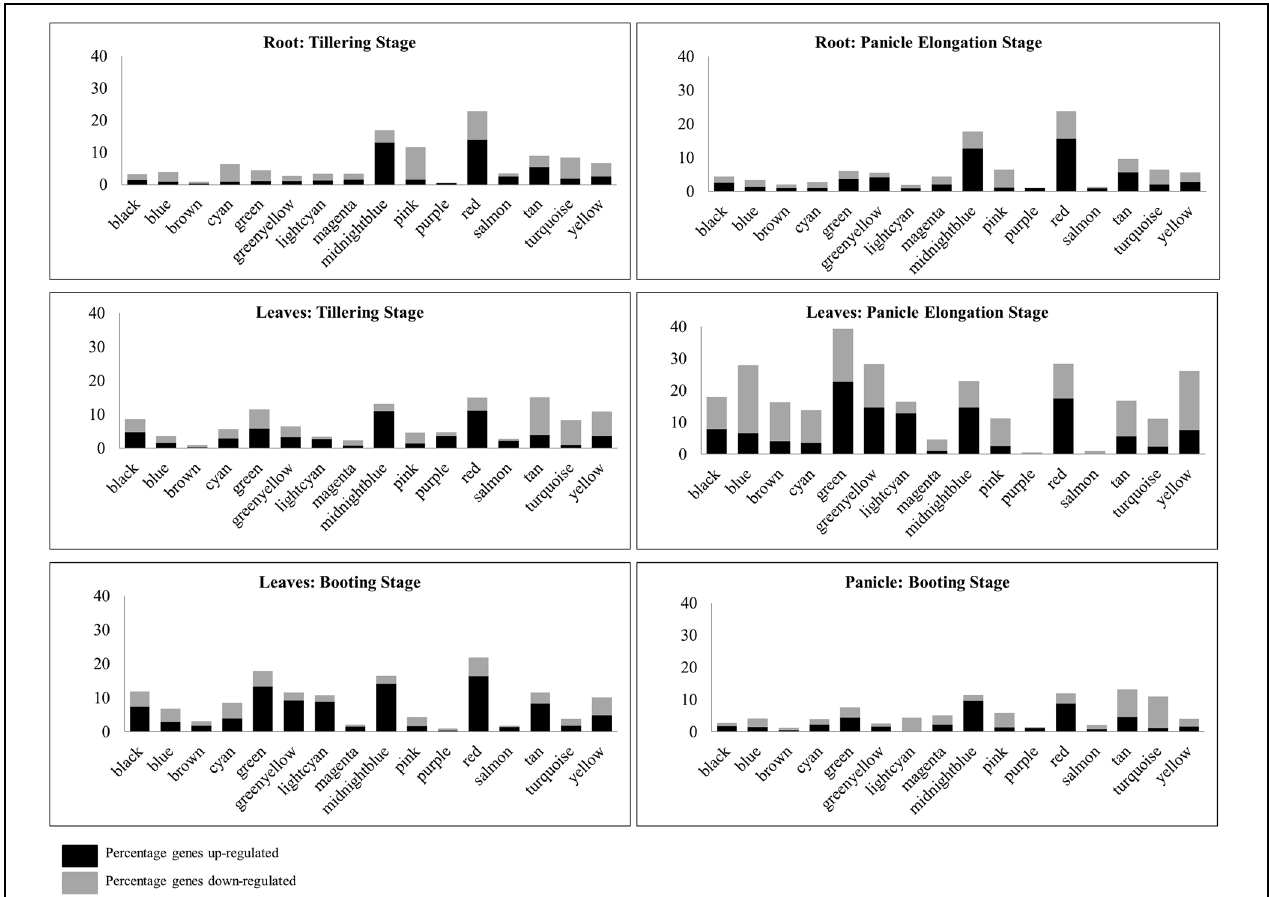
FIGURE 2 | Percentage of DEGs across tissues and developmental stages. The distribution of up- and down-regulated genes across modules in various tissues may help in identifying important processes being switched on or off in response to